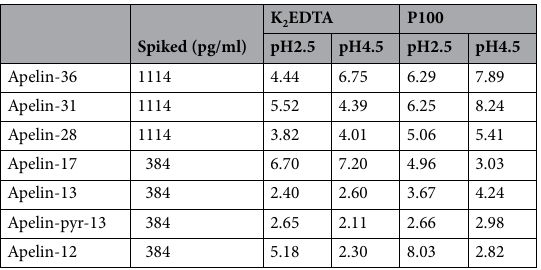
Table 5. Precision determination. Triple measurements after spiking of synthetic peptides on K 2 EDTA and P100 healthy plasma (n = 6) in non-acidified and acidified to pH4.5 and 2.5. Data is provided as the coefficients of variation (CV%).